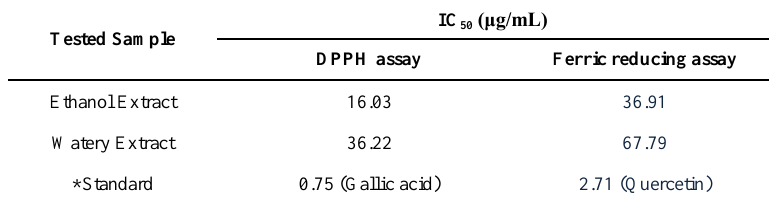
Table 4. Antioxidant activities of ethanol and watery extracts of the stem barks of Phyllanthus Albizzioides